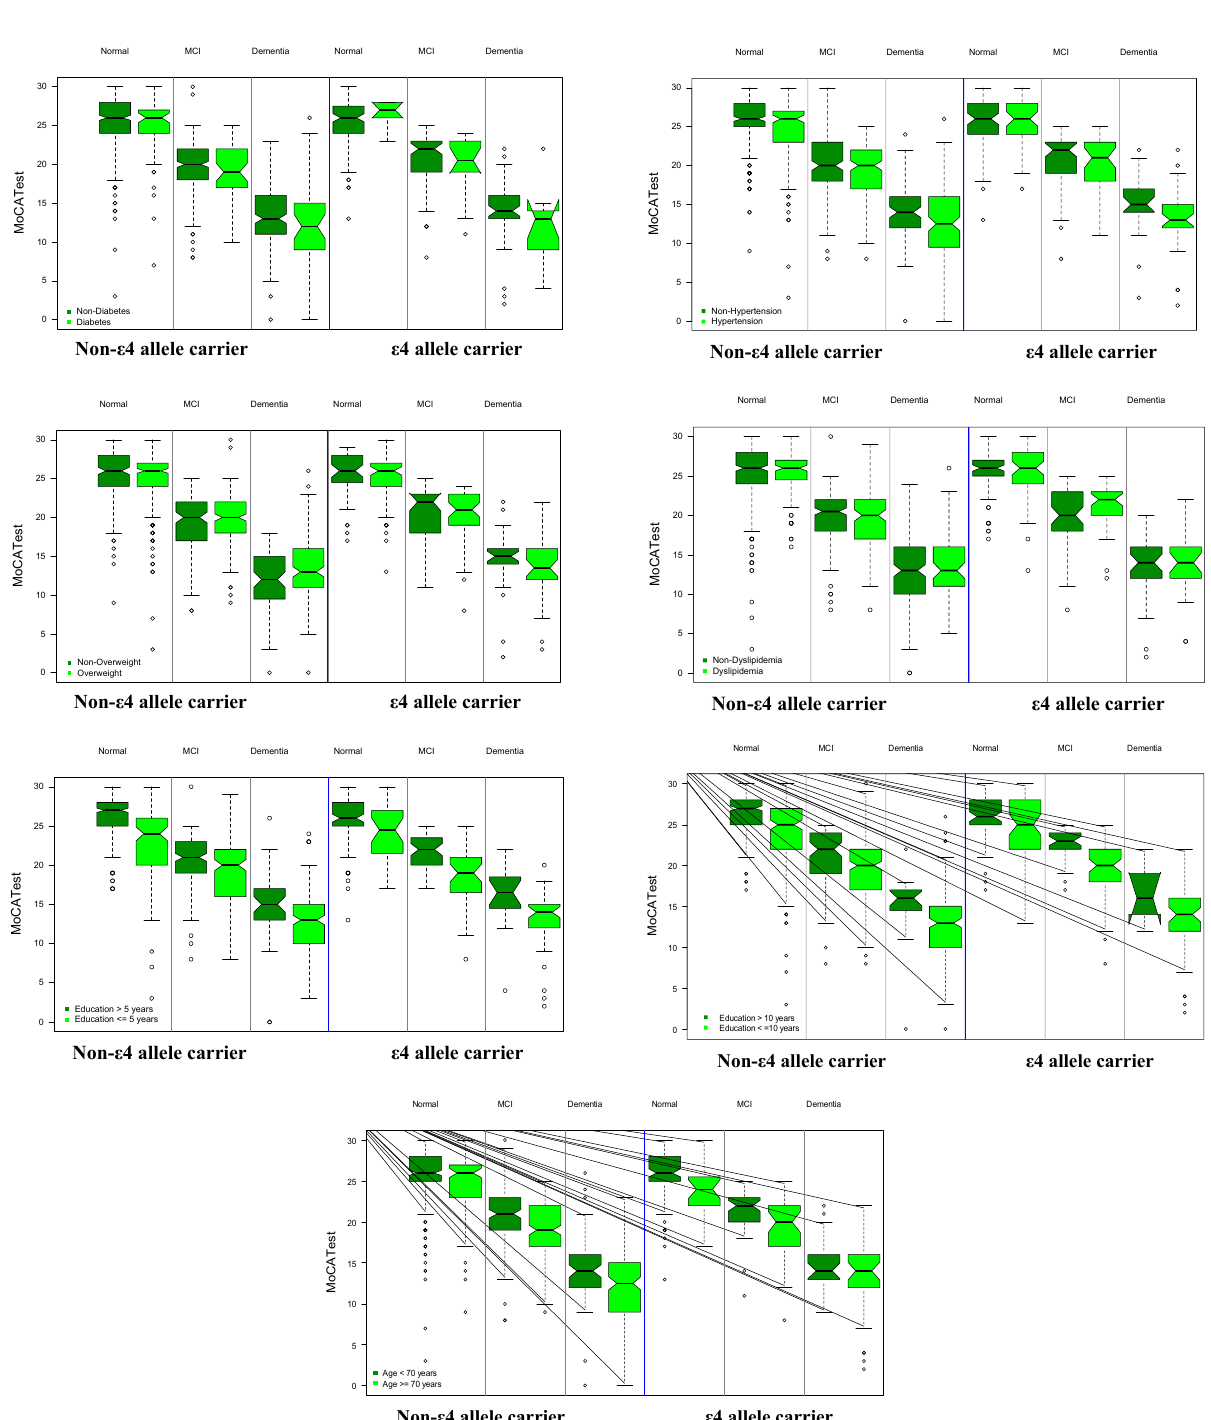
Figure 1. Performance in the Montréal Cognitive Assessment Test according to the carrier status or not of allele ε4, cognitive status and the presence or absence of the risk factor.